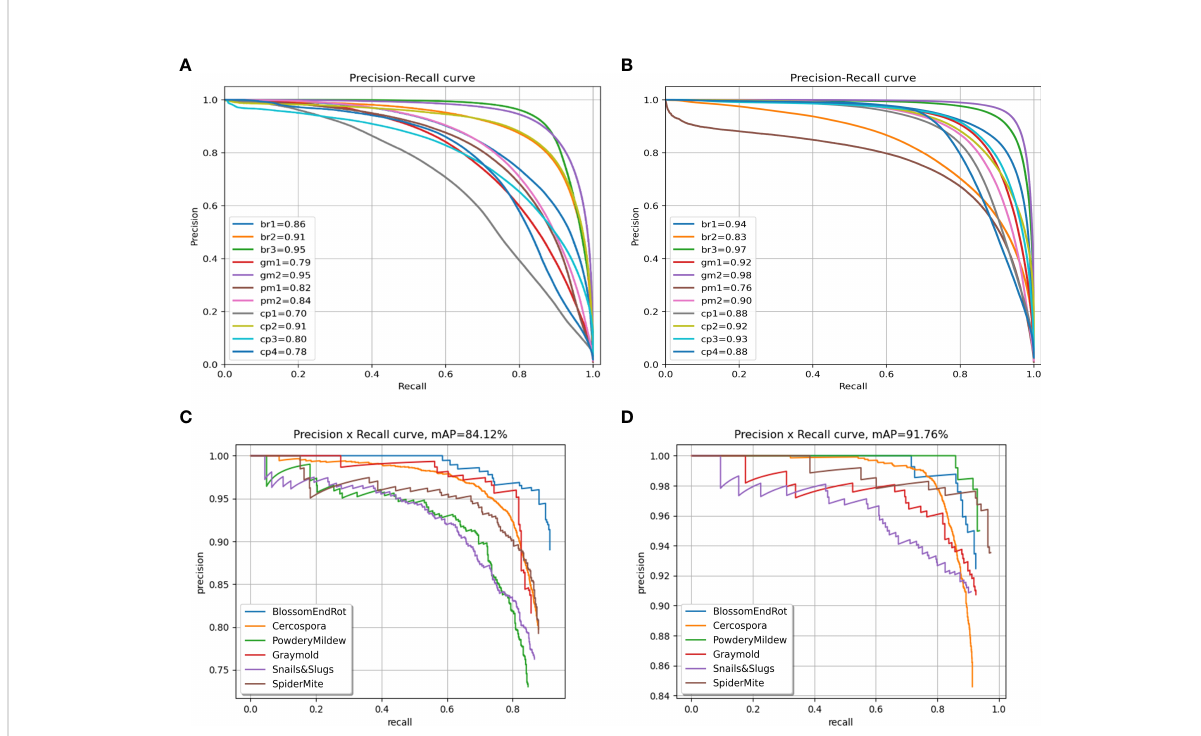
FIGURE 9 Precision-recall curves. (A) Decoupled DSA unit, (B) coupled DSA unit, (C) decoupled DDL unit, and (D) coupled DDL